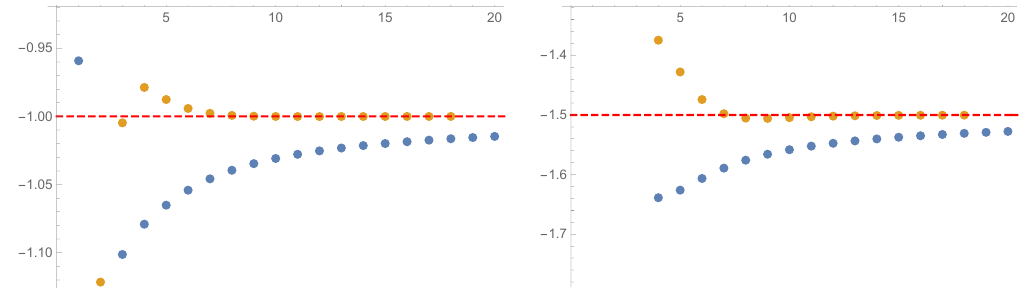
Figure 3 . The (cid:12)gure in the left (respectively, right) shows the sequence (3.29) and its second Richardson transform for the O( N ) sigma model, where N = 4 and N = 6, respectively. The horizontal dashed line is the expected value 2(cid:1) (cid:0)